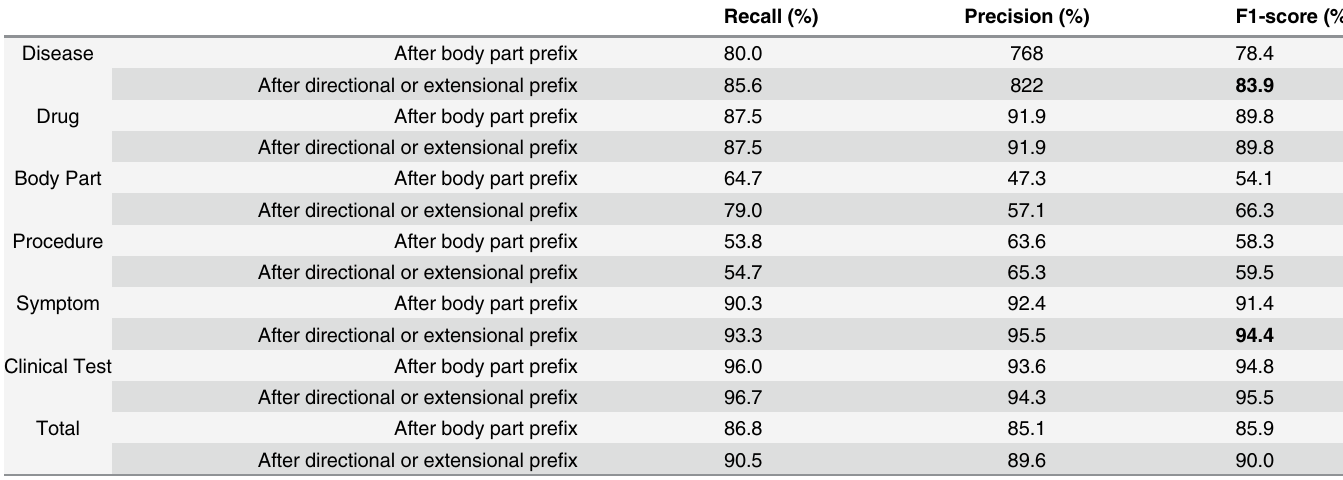
Table 3. Term recognition after prefix